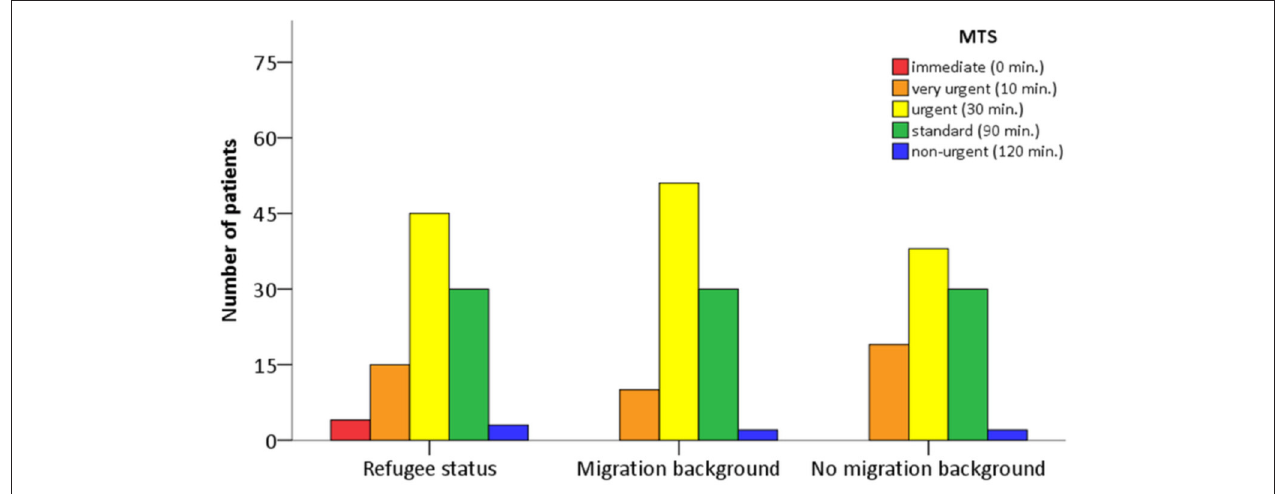
FIGURE 2 | Manchester Triage (MTS) of patient groups on